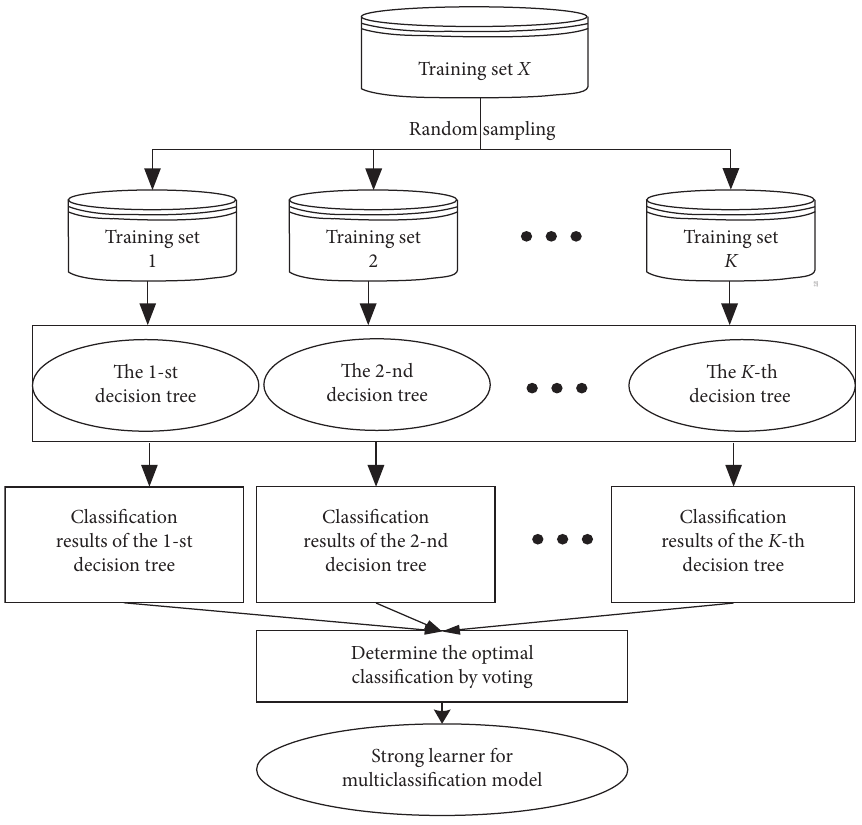
Figure 1: Flow chart of RFs